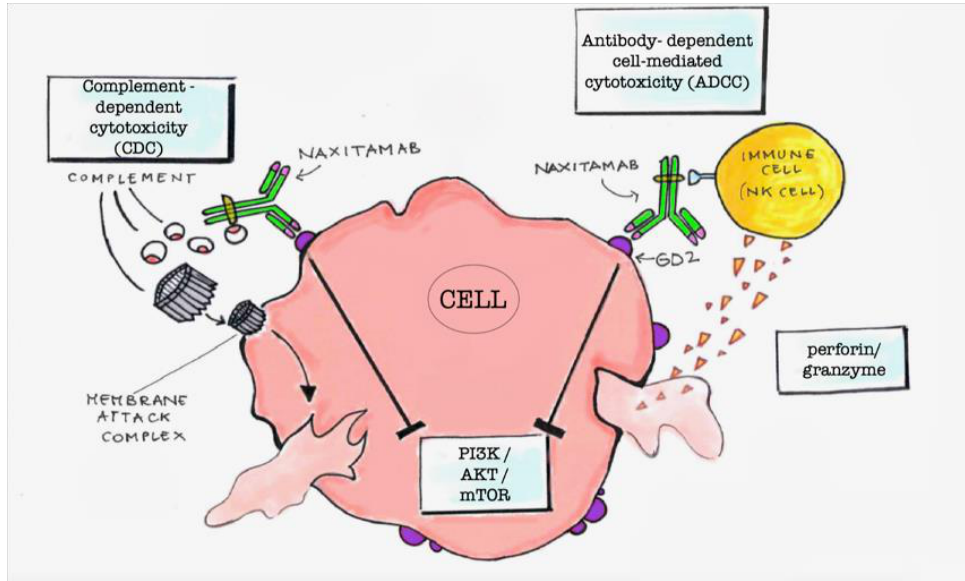
Figure 1. Schematic representation of cytotoxicity induced by anti-GD2 antibodies. Complement- dependent cytotoxicity (CDC) is due to the formation of the membrane attack complex following the antibody linkage with GD2 that triggers activation of the complement proteins. The membrane attack complex disrupts the cell membrane causing cell death. Antibody-dependent cell-mediated cytotoxicity (ADCC) is due to activation of immune cells such as macrophages, NK cells, or granulocytes by linkage of the Fc region of the anti-GD2 antibody with the Fc γ receptors of these cells. The Fc-Fc γ linkage triggers phagocytosis by macrophages or destruction of the tumor cells by the perforins and granzymes secreted by NK cells and granulocytes. A further mechanism is the down- regulation of PI3K/Akt/mTOR signaling network triggered by the Fc- Fcγ linkage.